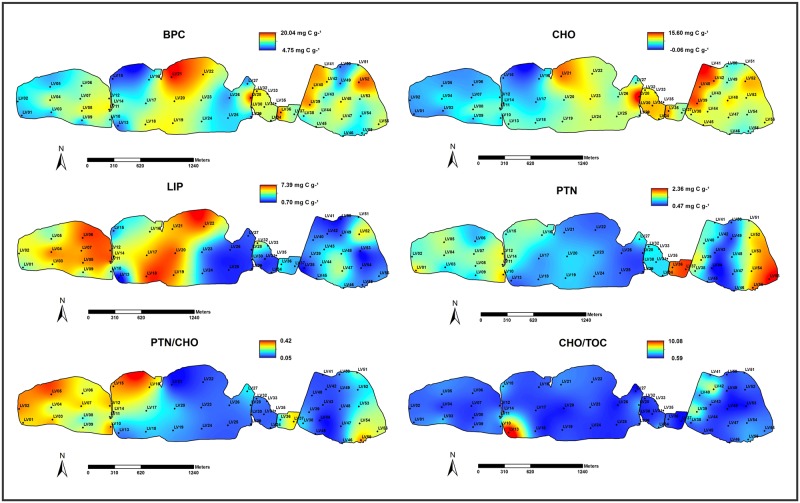
Distribution maps of biopolymeric carbon (BPC; mg C g-1), carbohydrate (CHO; mg C g-1), lipid (LIP; mg C g-1) and protein (PTN; mg C g-1) concentrations, and PTN/CHO and CHO/TOC ratios values.